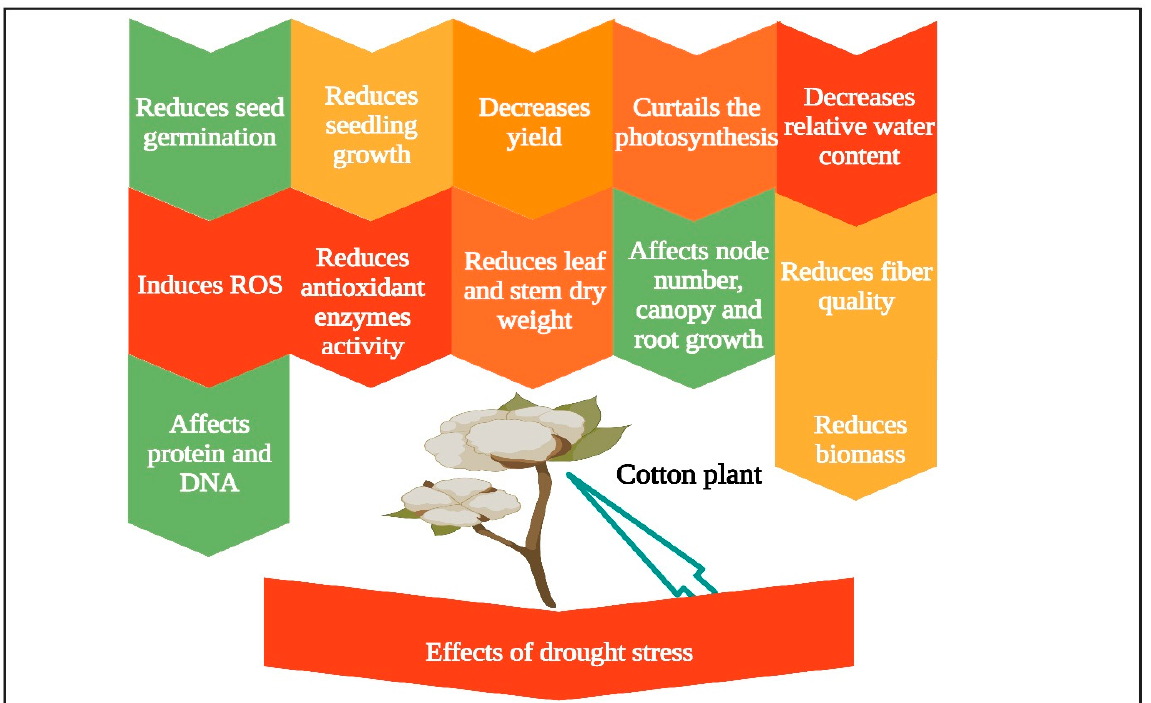
Figure 1. Drought stress affects cotton seed germination, reduces seedling growth, reduces yield, induces ROS, and decreases antioxidant activity and fiber quality. This figure was made with Bio- render.com.